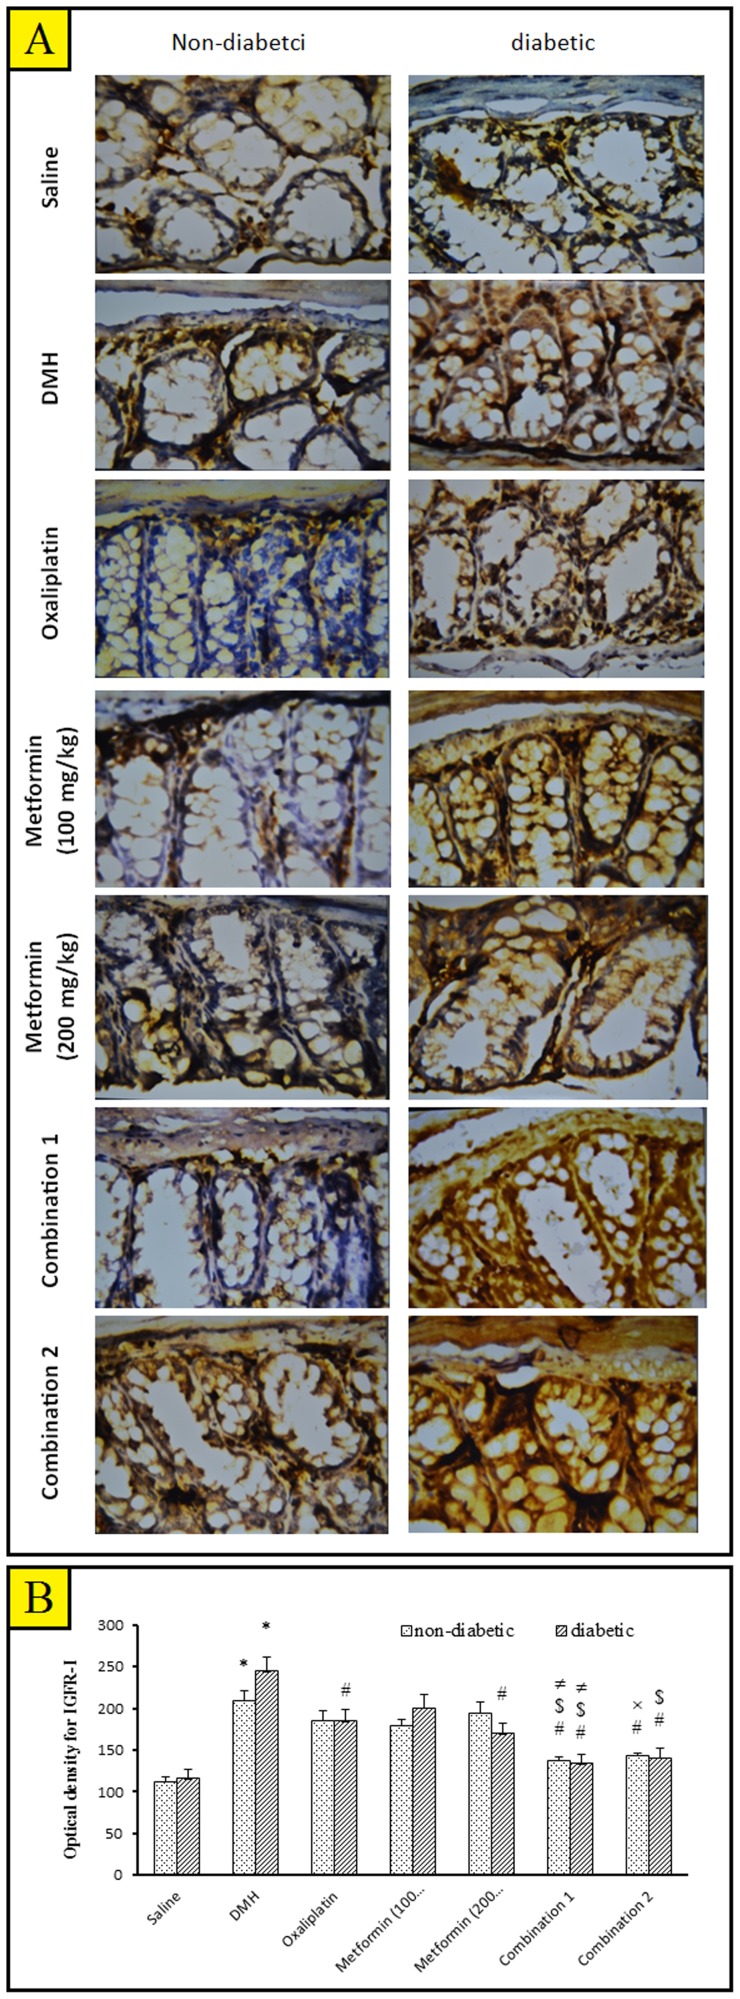
Effect of different pharmacologic treatments on the optical density for IGF-R1 in the colon tissue.
A) Photomicrographs for colon tissues immunohistochemically stained for IGF-R1 (scale bar  = 238.2 µm). B) A bar chart demonstrating the optical density for IGF-R1 immunostaining in non-diabetic and diabetic mice. Mice [except saline groups] were injected with 1,2-dimethylhydrazine (DMH) weekly for 15 week to induce colon cancer then treated with oxaliplatin and/or metformin (100 or 200 mg/kg) for 4 weeks. Results are expressed as mean ± S.E.M. and analyzed using two-way ANOVA followed by Tukey's post-hoc test at P<0.05. *Significantly different from saline group. #Significantly different from DMH group. $Significantly different from oxaliplatin group. ≠Significantly different from metformin (100 mg/kg) group. ×Significantly different from metformin (200 mg/kg), n = 5–6.